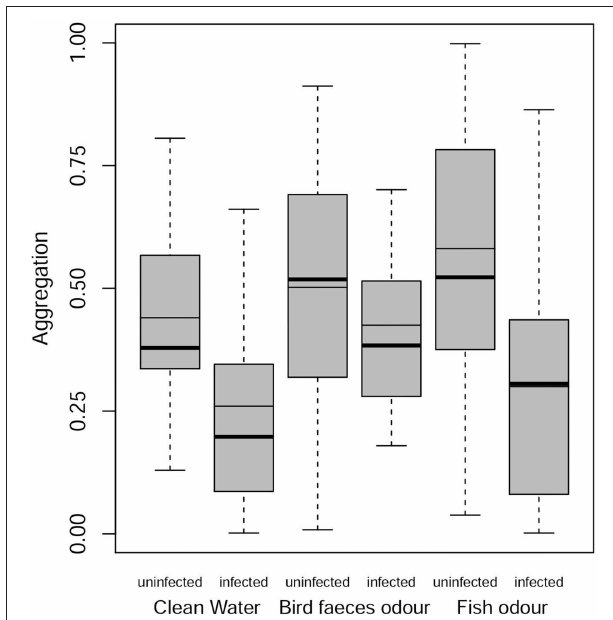
FIGURE 3 | Aggregation behavior of infected and uninfected G. insensibilis . Aggregation behavior (total time spent in close contact with the conspecific group found within the tea ball) as a function of the gammarid infection status (uninfected or infected with M. papillorobustus ) and water condition (control or the presence of fish [non-host] or bird [definitive host] predator odors). The meaning of the graphical elements is the same as in Figure 2 . Notice that in the last box, the mean is equal to the